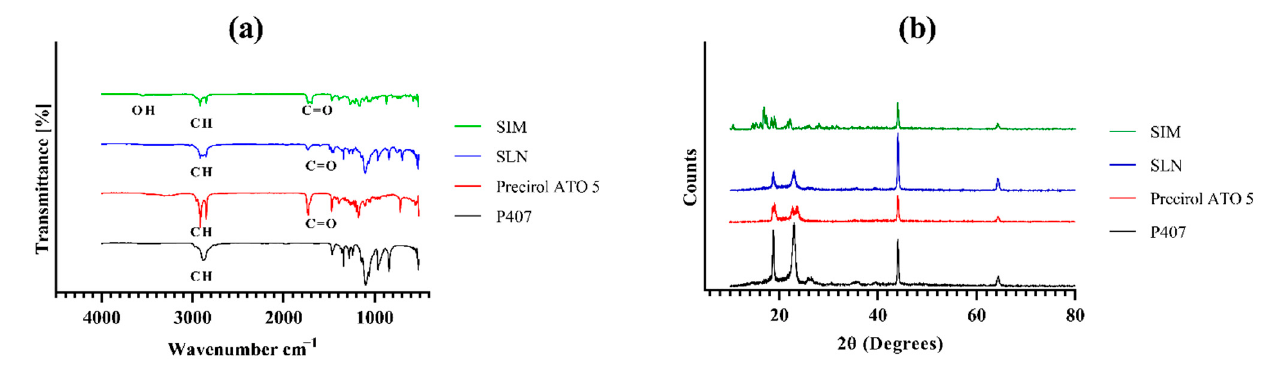
Figure 3. ( a ) FTIR and ( b ) PXRD spectrum of SIM, SLN formulation, Precirol ATO 5 and P407.